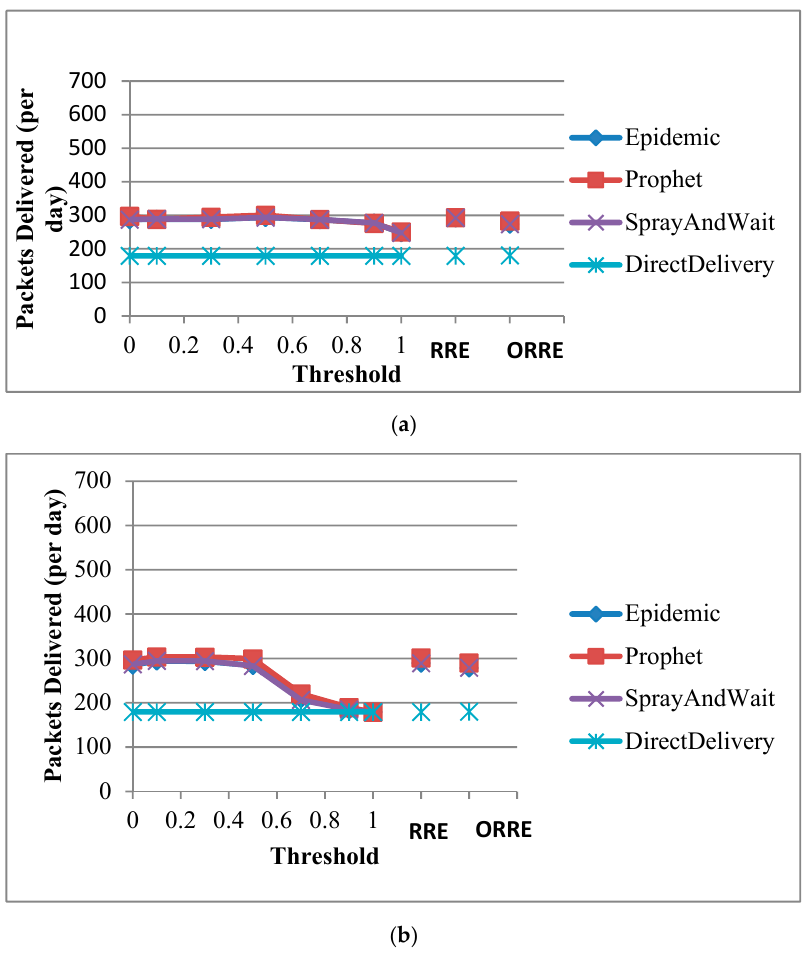
Figure 8. Packets delivered for ten nodes for ( a ) pigeon and ( b ) flying fox scenarios.